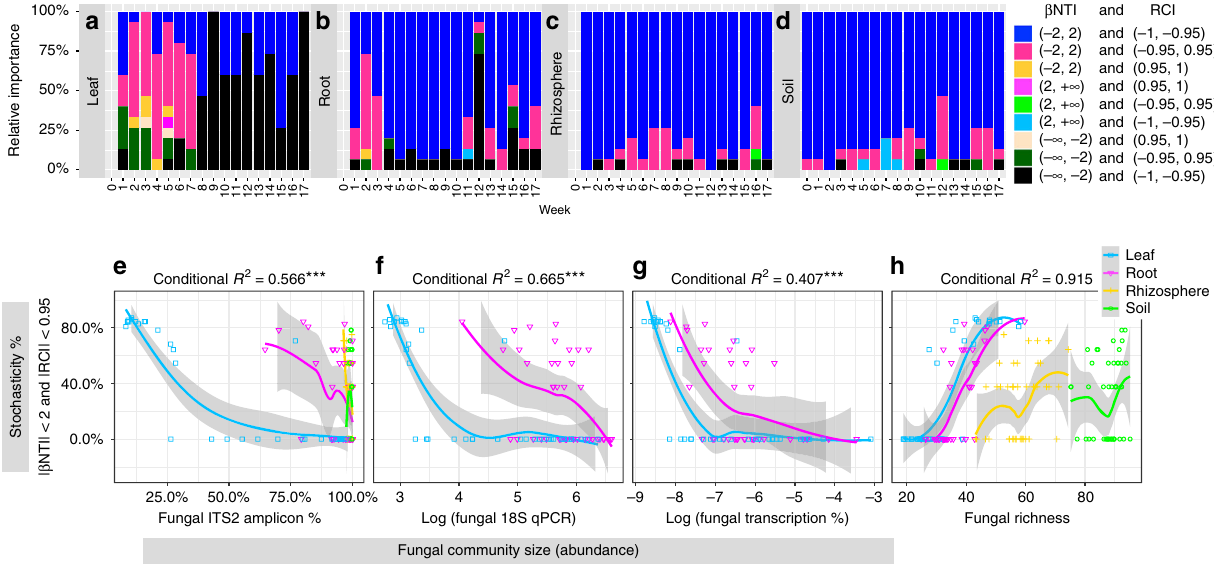
Fig. 4 Stochasticity and ecological drift in community assembly. a – d Stochasticity is detected from values of two indices, β -Nearest Taxon Index ( β NTI) and Raup-Crick Index (RCI). Where | β NTI| < 2 and |RCI| < 0.95 (red bars), compositional variance is most likely due to stochasticity, which in this range is independent from dispersal and selection. Note that stochasticity is dominant in early time points in leaves and roots. Selection is favored as the force for community assembly where β NTI ≤ − 2 and RCI ≤ − 0.95 (black). Here, communities are more clustered than expected by chance both phylogenetically and ecologically, likely due to homogenous selection. Where | β NTI| < 2 and RCI ≤ − 0.95 (blue), communities are ecologically more clustered than by expected by chance but phylogenetically stochastic. In this case, community composition can be a result of either homogenous selection or homogenous dispersal and, of the two choices, homogenous selection is preferred due to the observed strong selection by host compartment and time, as demonstrated in Fig. 2A and Supplementary Data 4. ( e – g ) Stochasticity and community size. Ecological drift can be strengthened when the stochastic component of compositional variance is negatively correlated with community size. Here, we demonstrate this correlation when community size is estimated in three different ways: e fungal rDNA, internal transcribed spacer (ITS2) reads as a percentage of total ITS2 reads ampli fi ed from fungal plus sorghum host DNA, f fungal 18S rDNA amount assessed by real-time or quantitative PCR ampli fi cation and g fungal RNA as a percentage of fungal plus plant reads found in the transcriptomes of sorghum leaves and roots. h Stochasticity and richness. Ecological drift is suggested by a positive correlation between fungal richness and the stochastic component of compositional variance, as shown here. Source data are provided as a Source Data fi